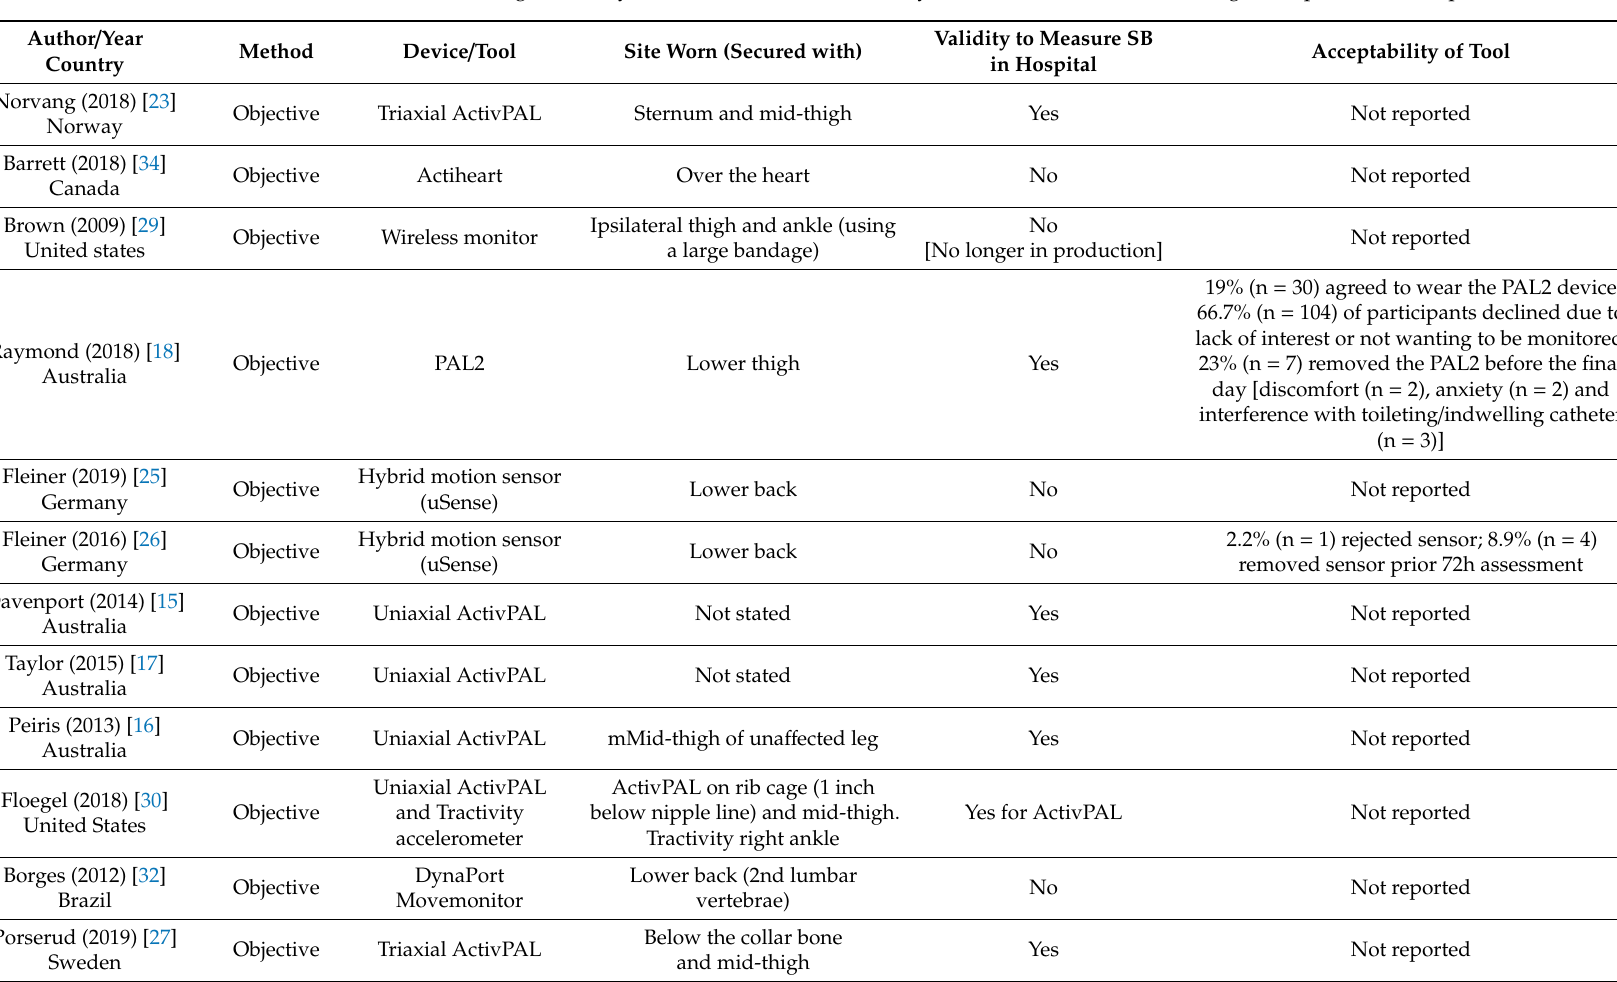
Table 2. Characteristics of tools measuring sedentary behaviour (SB) and sedentary behaviour bouts (SBBs) among older patients in